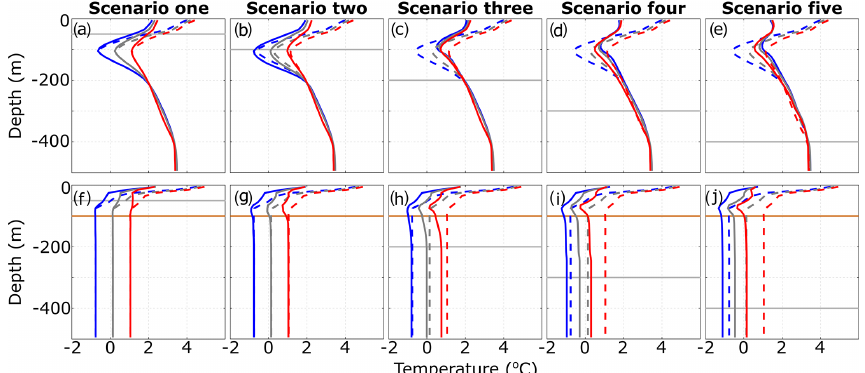
Figure 4. Steady-state glacier-adjacent water temperature for a range of initial Polar Water conditions. In all plots, solid and dashed lines indicate simulations with and without icebergs, respectively. Panels (a) – (e) show configurations with a flat-bottomed domain, whilst (f) – (j) show those with a 100m deep sill. Grey, blue and red lines show scenarios using the BCstandard , PWcool and PWwarm boundary conditions, respectively (shown in Fig. 1e). The horizontal grey lines indicate the maximum iceberg keel depth in each scenario, and the horizontal orange lines in panels (f) – (j) indicate the sill depth.